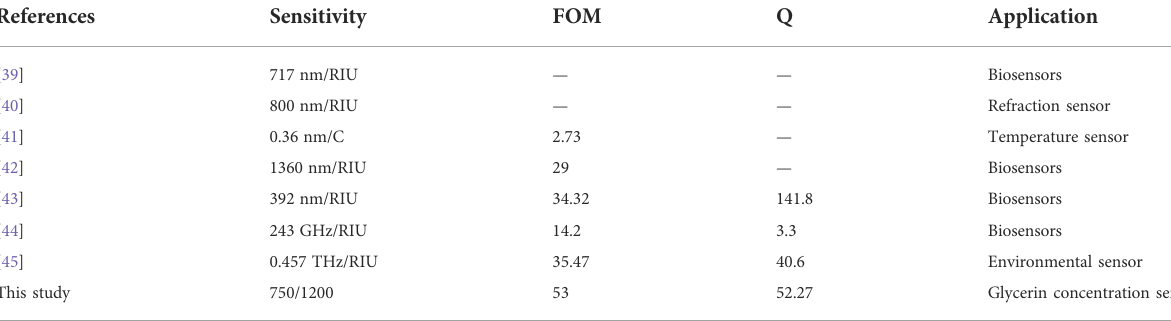
TABLE 3 Comparison table of proposed structures with previously. Published